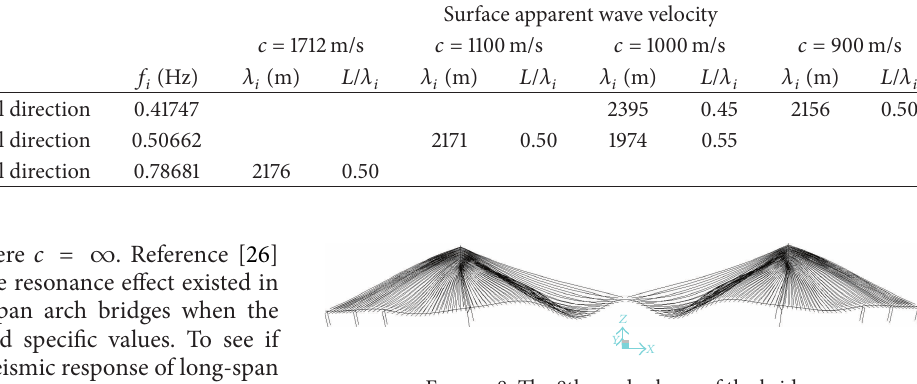
Figure 8: The 8th mode shape of the bridge.